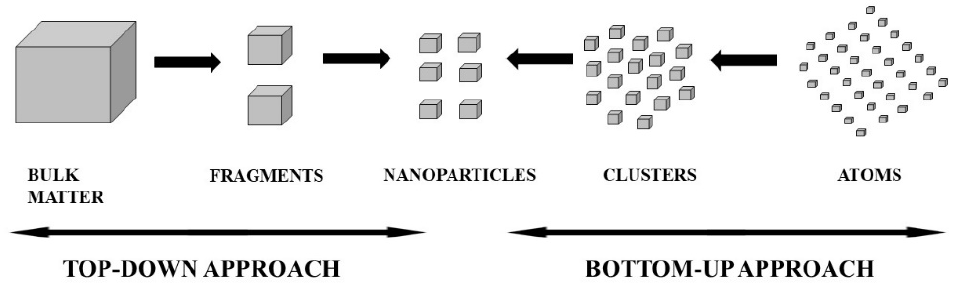
Figure 3. A summary of the general techniques utilised in the manufacturing of MNPs.